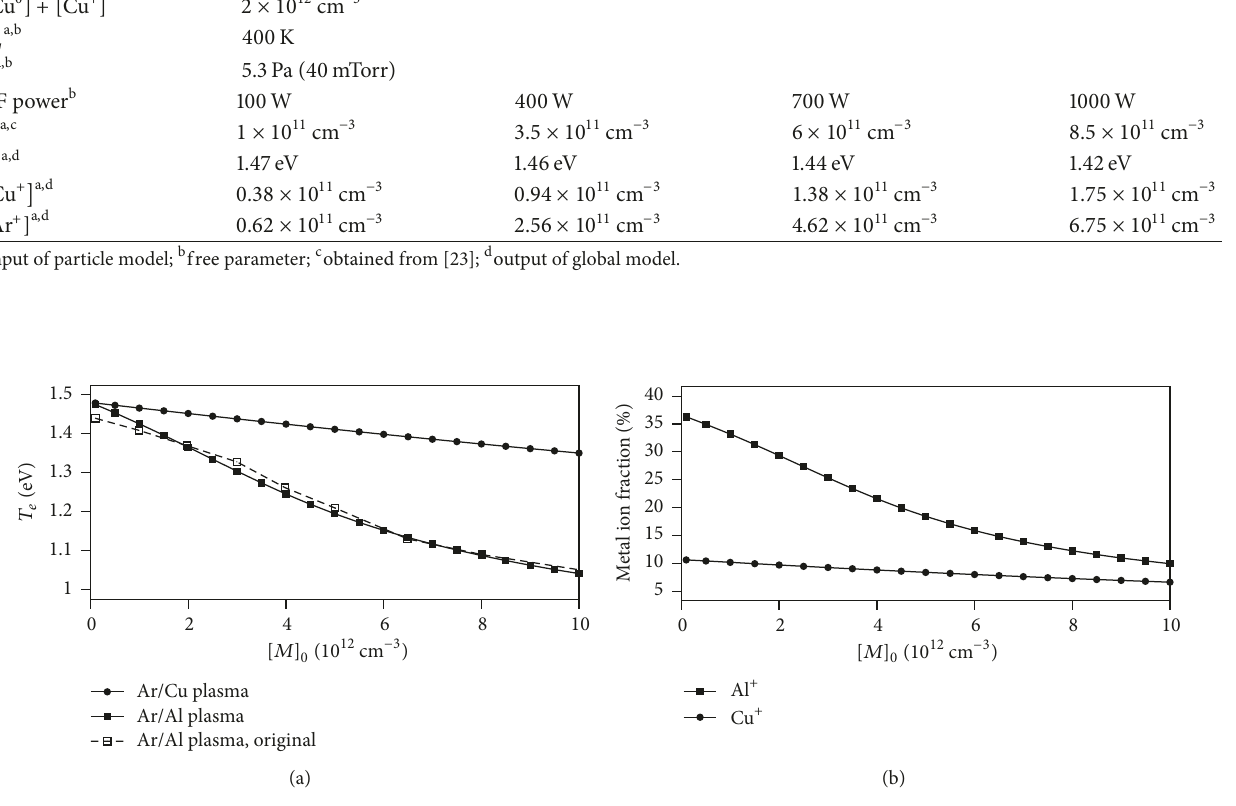
Figure 2: Validation of the global model and comparison of results for Al and Cu. (a) Electron temperature and (b) metal atoms ionization degree versus total average density of metal atoms in the